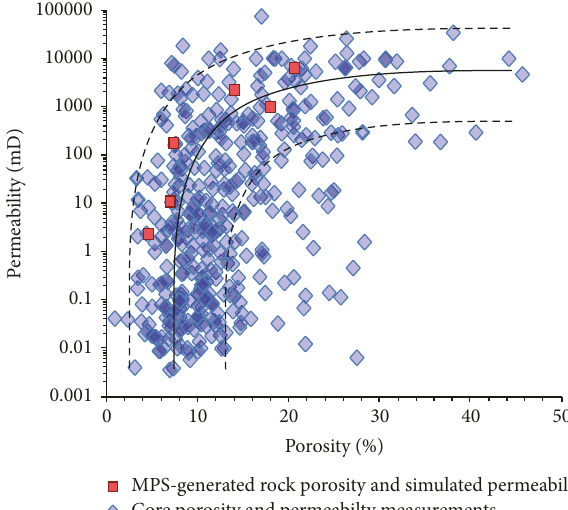
Figure 20: Porosity-permeability plot of continental carbonate samples: Palabos permeability simulation results on computer- generated rock volumes are indicated in